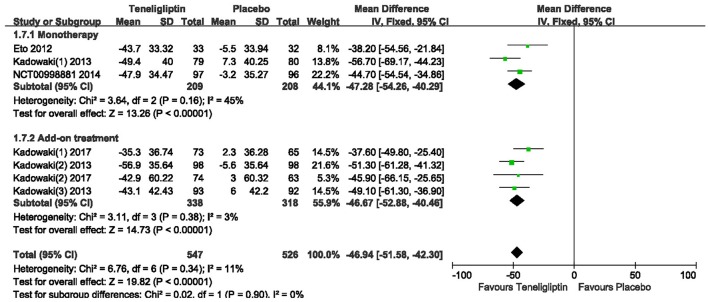
Effects of teneligliptin and placebo on 2 h PPG change from the baseline by meta-analysis.